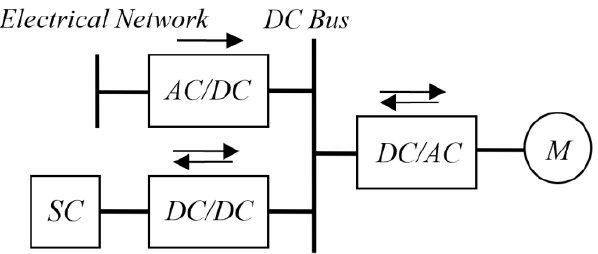
Figure 10. A combined crane electric drive system with mains supply as the main energy